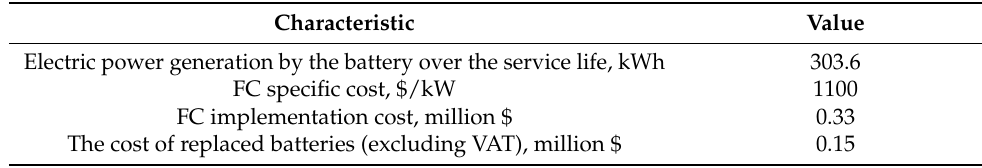
Table 4. Characteristics of a fuel cell functioning as a rechargeable battery.